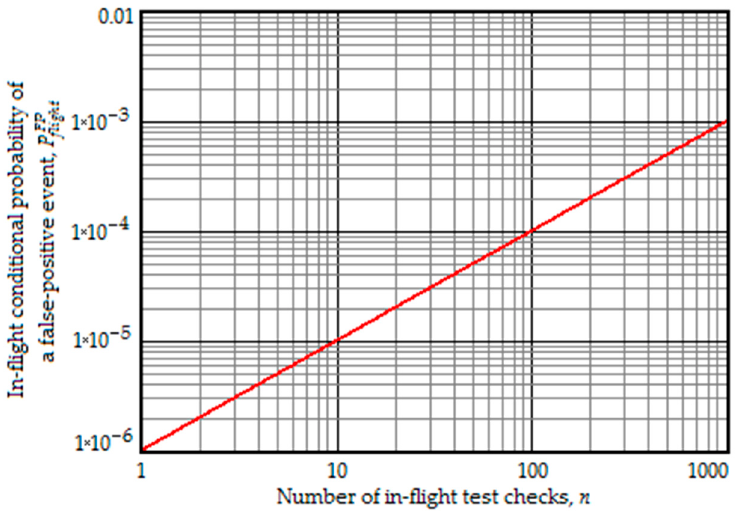
Figure 2. The dependency of the in-flight conditional probability of a false-positive event on the number of test checks.